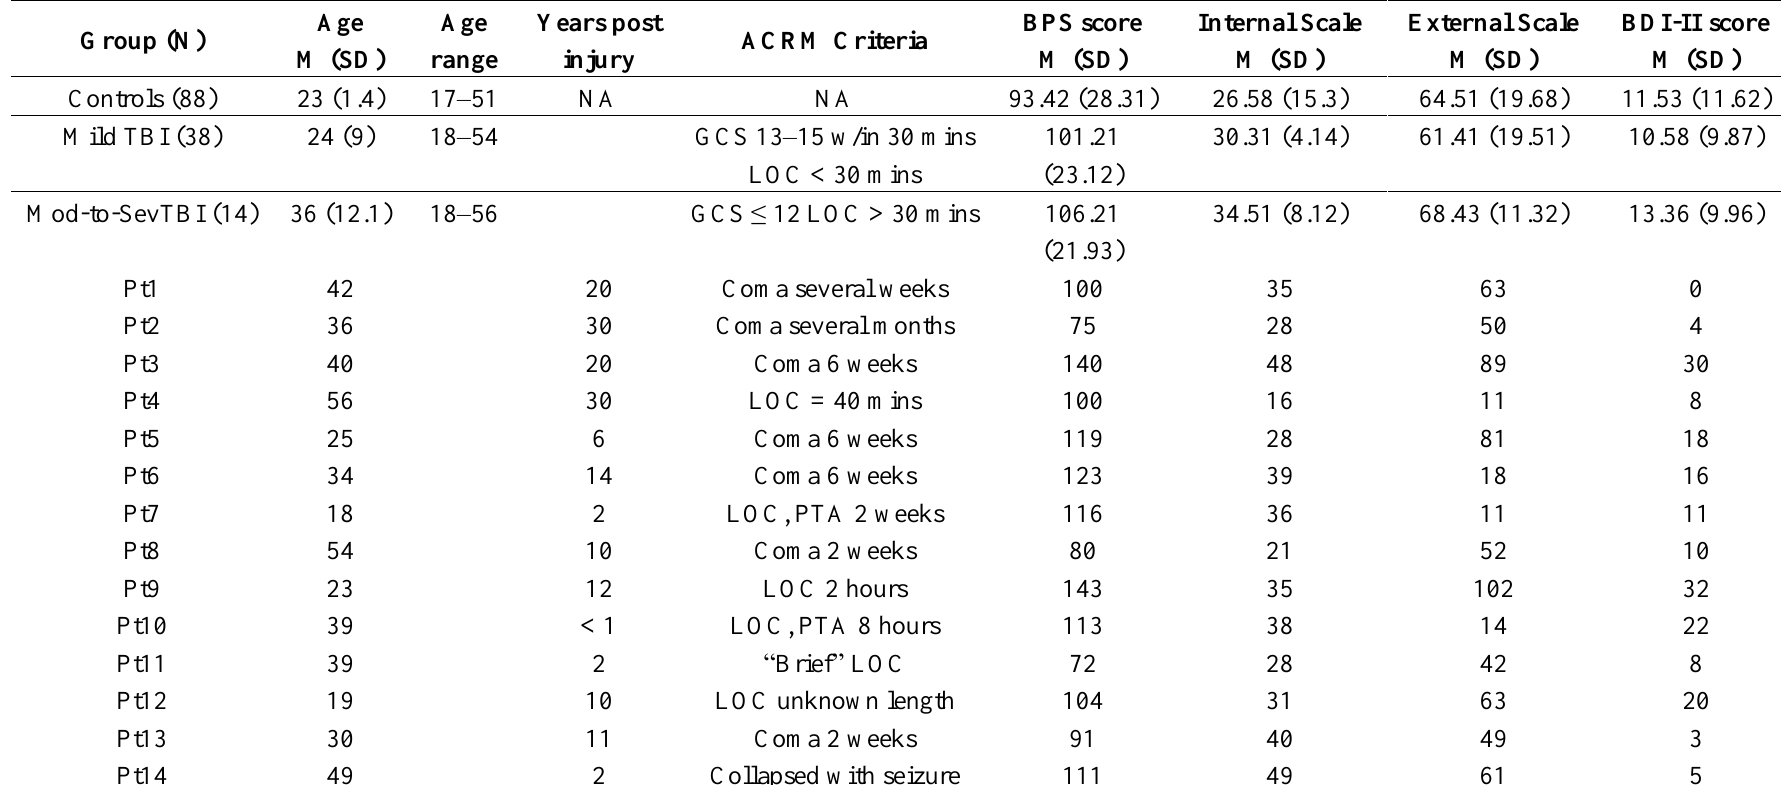
Table 1 . Participant Characteristics for the current